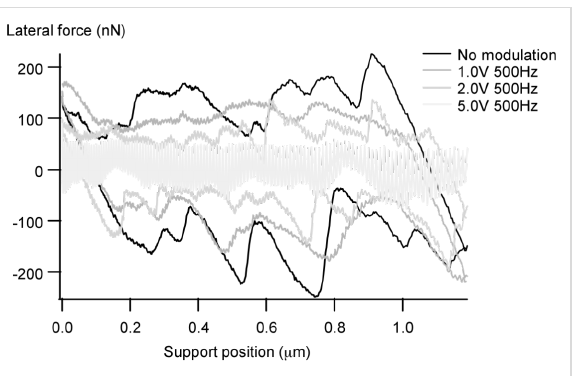
Figure 8: Modulation of the normal force at a frequency much higher than the frequency of the stick-slip events results in a significant decrease in the friction, and the appearance of a modulation signal in the lateral force. A voltage of 5.0 V is equivalent to 280 nN modulation peak–peak (linear scale) of the normal load. The average normal load is held constant at 50 nN. [Reprinted with permission from van Spengen, W. M.; Wijts, G. H. C. J.; Turq, V.; Frenken, J. W. M. J. Adhes. Sci. Technol. 2010, 24, 2669–2680.]